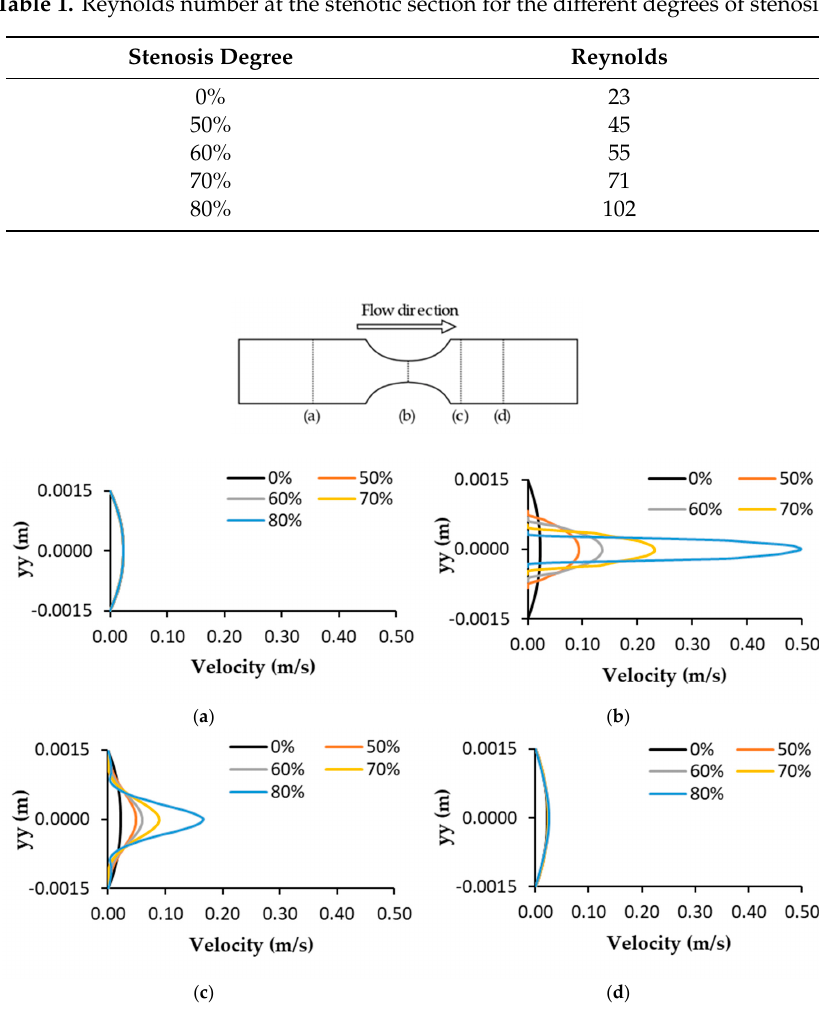
Table 1. Reynolds number at the stenotic section for the different degrees of stenosis.